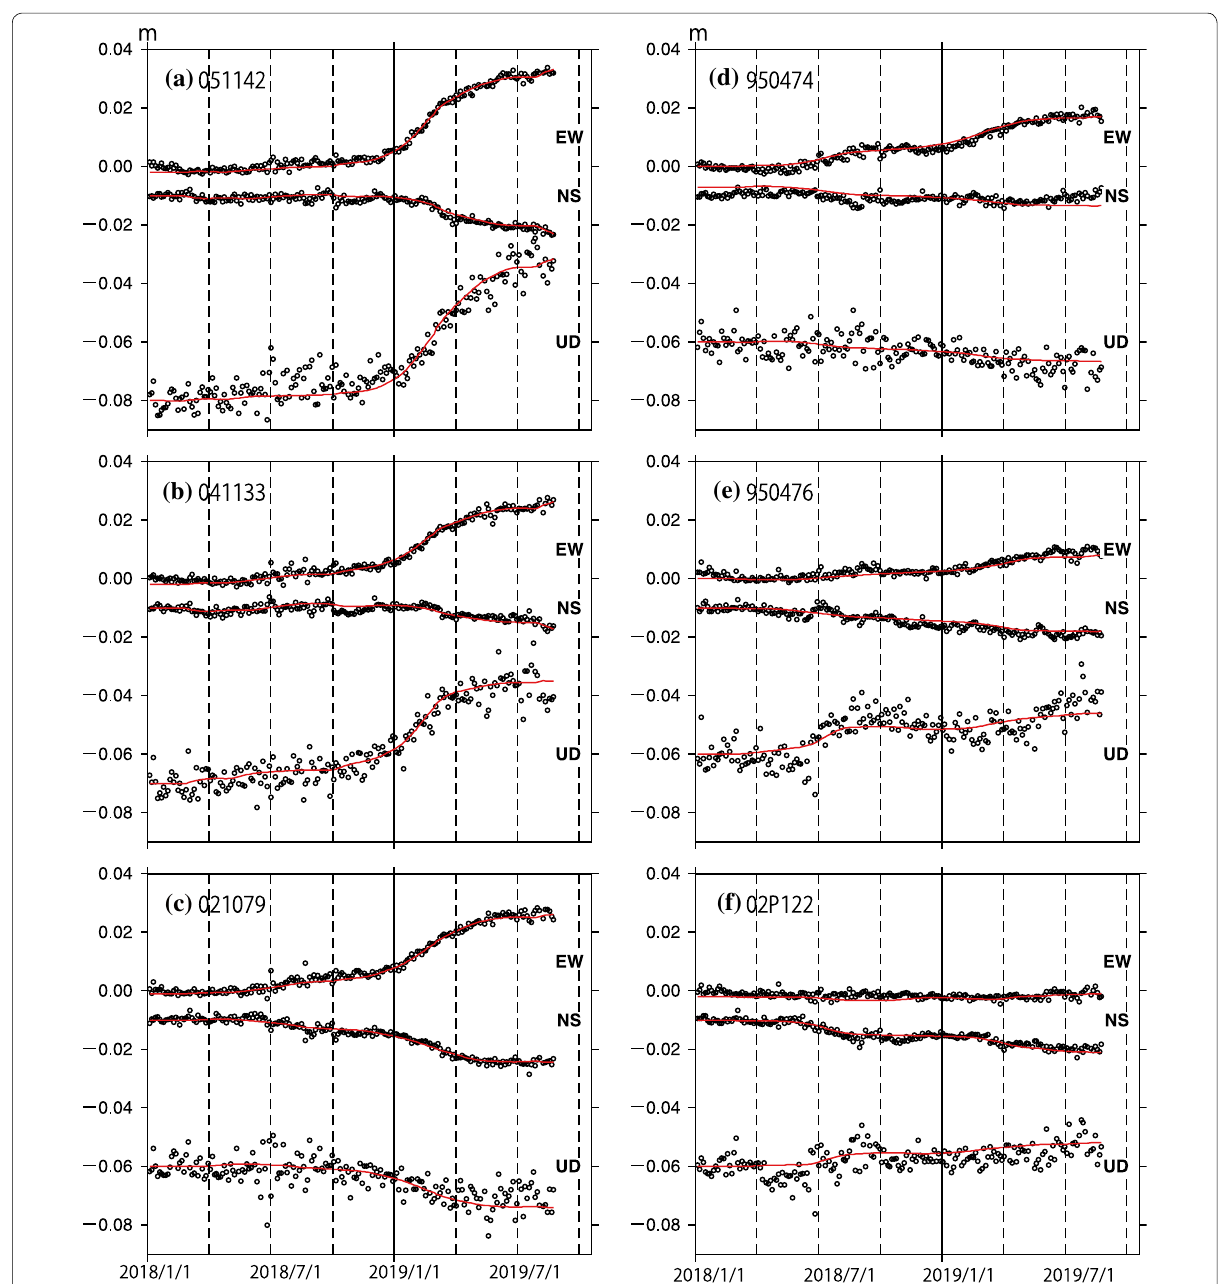
Fig. 2 Detrended position time series averaged over 3 days at selected GNSS sites relative to the 950462 site. The locations of these sites are shown in Fig. 1a, b. EW, NS, and UD indicate east–west, north–south, and up–down components with eastward, northward, and upward positive, respectively. Red lines show the computed transient from our optimal model. a 051142. b 041133. c 021079. d 950474. e 950476. f